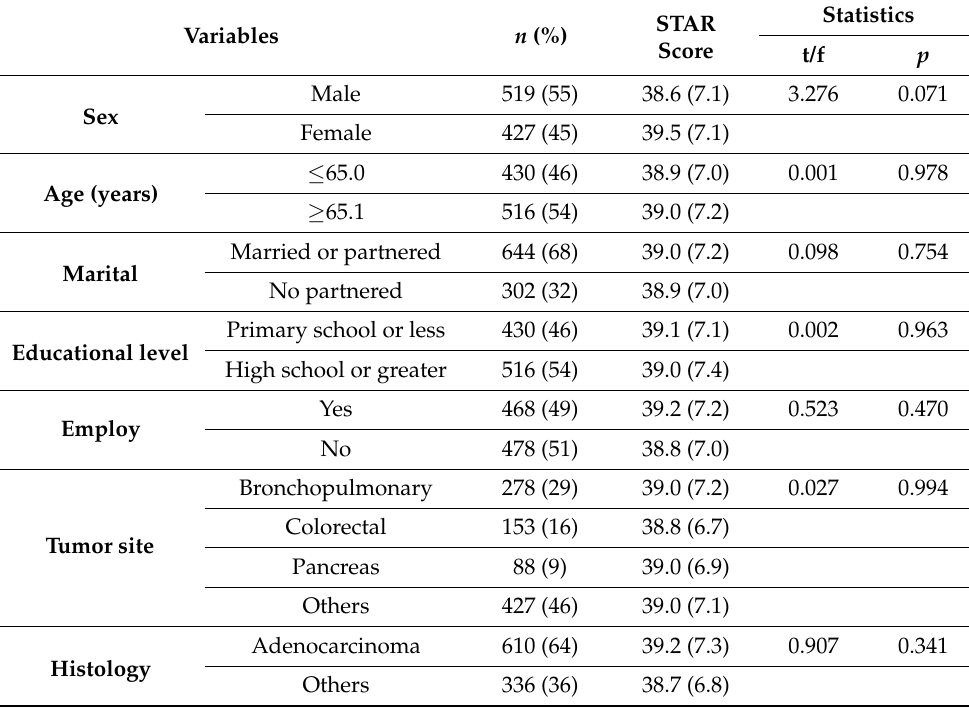
Table 1. Baseline characteristics and alliance therapeutic score ( n =